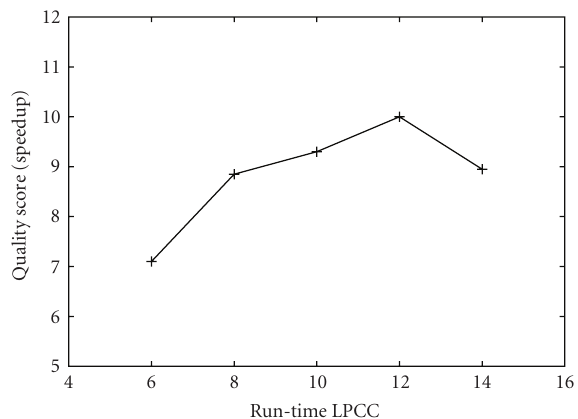
Figure 9: Quality scores (speedups) for di ff erent run-time LPCCs, the estimated LPCC order during compile-time is 12.